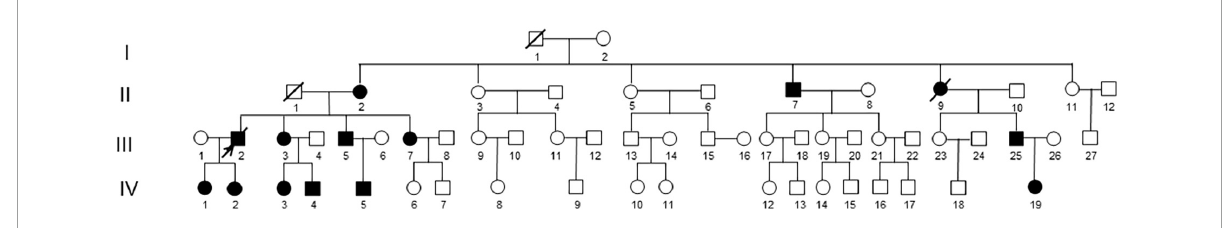
FIGURE1 Lineage of a family with prevalent CD caused by an R124L mutation (I1 and I2 were inbred, IV: 2 was 2 years of age).